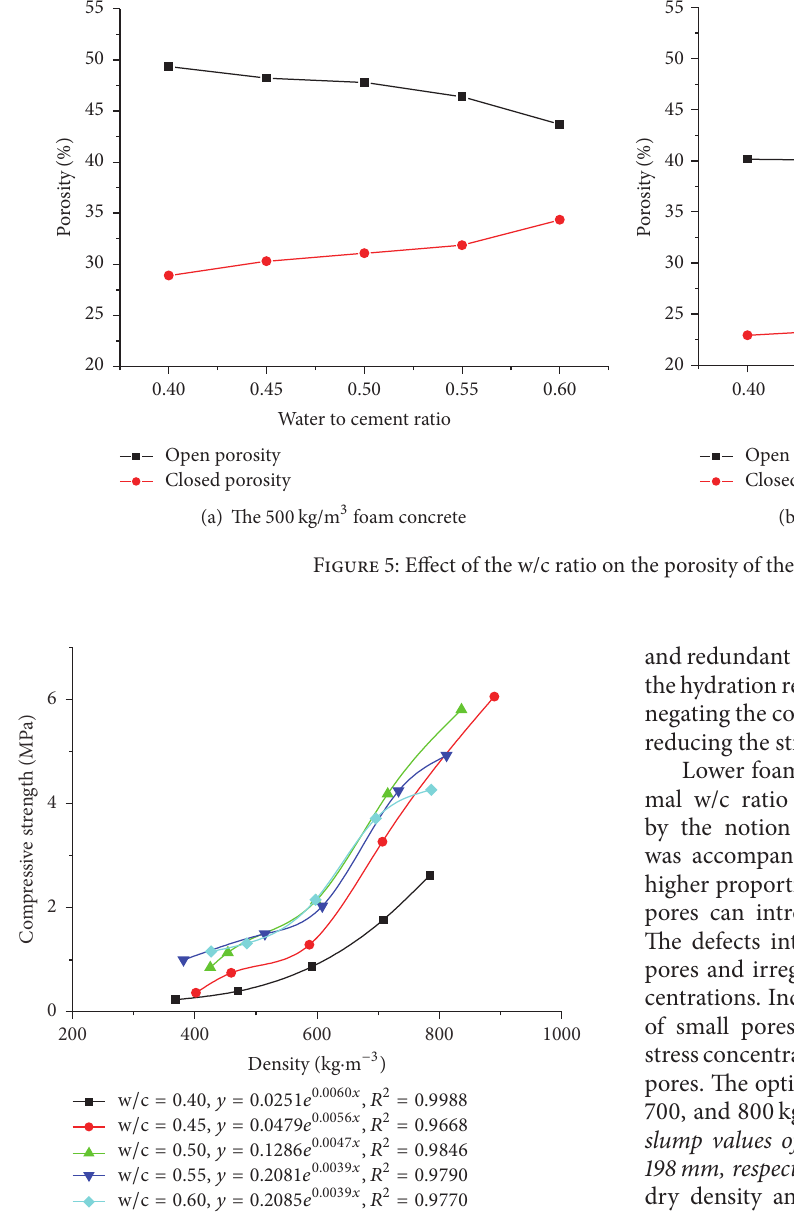
Figure 6: The fitting relationships between the strength and dry density of foam